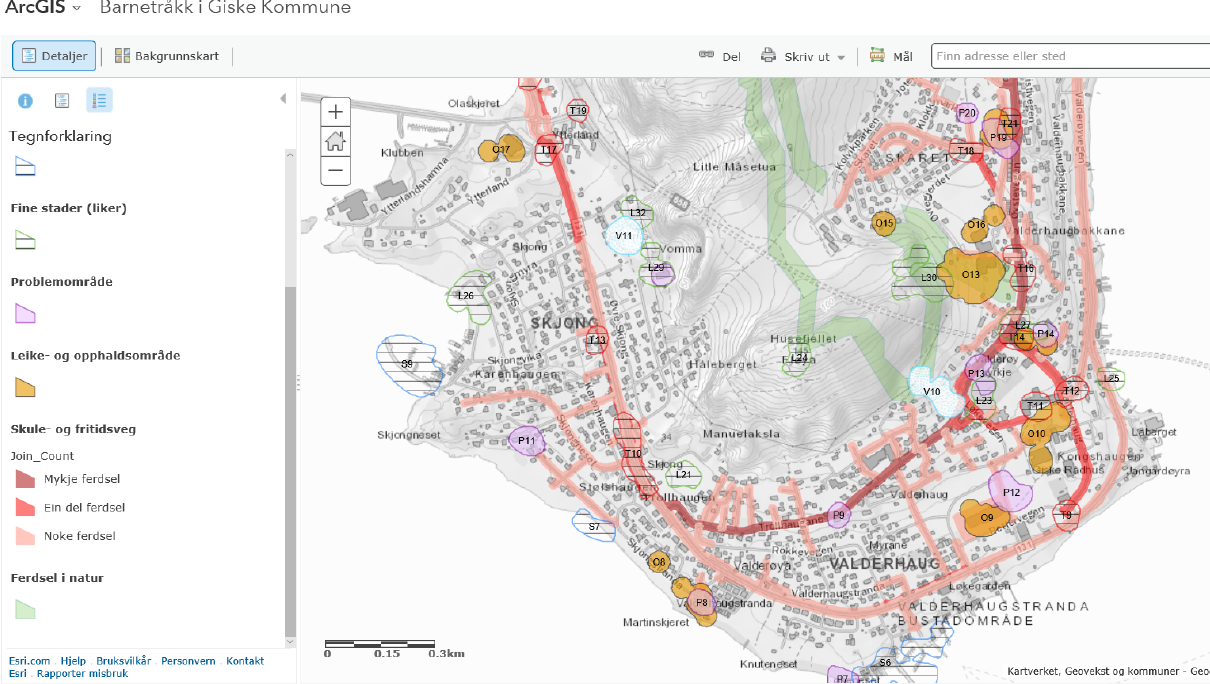
Figure 5. Illustration from the municipality of Giske (Giske Municipality,